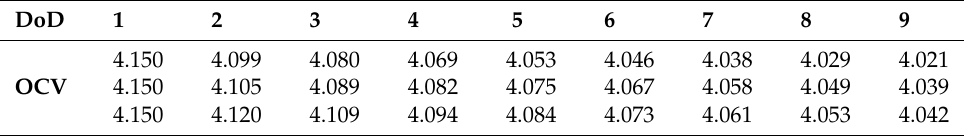
Table A1. OCV models parameters for DoD from 1% to 9%.